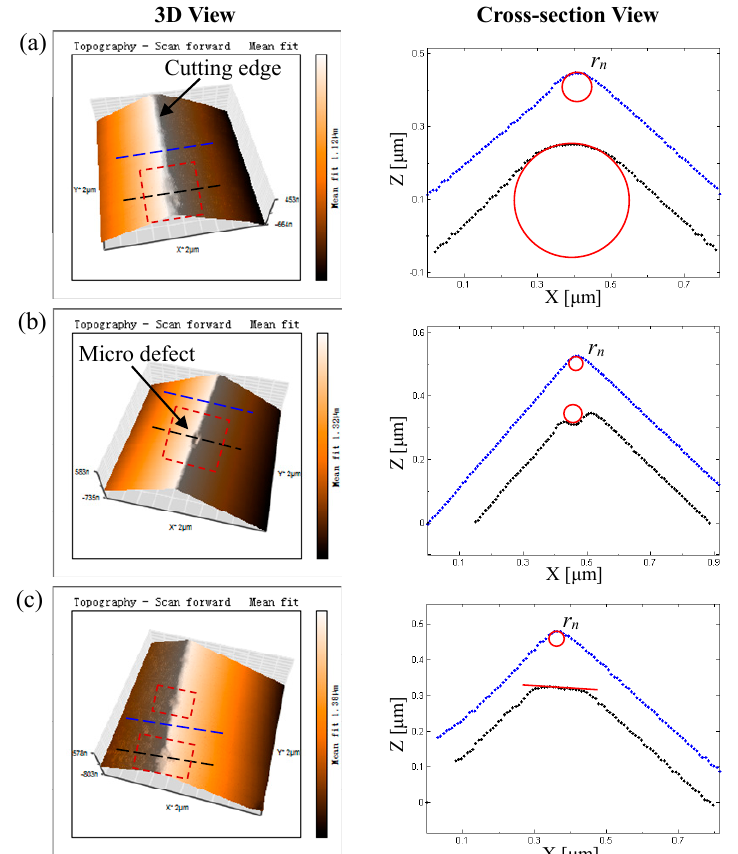
Figure 2. Three types of the tool-edge micro defects measured by atomic force microscopy (AFM) in 3D view and its corresponding cross-section: ( a ) blunt-edge micro defect; ( b ) crescent-edge micro defect; ( c ) flat-edge micro defect.